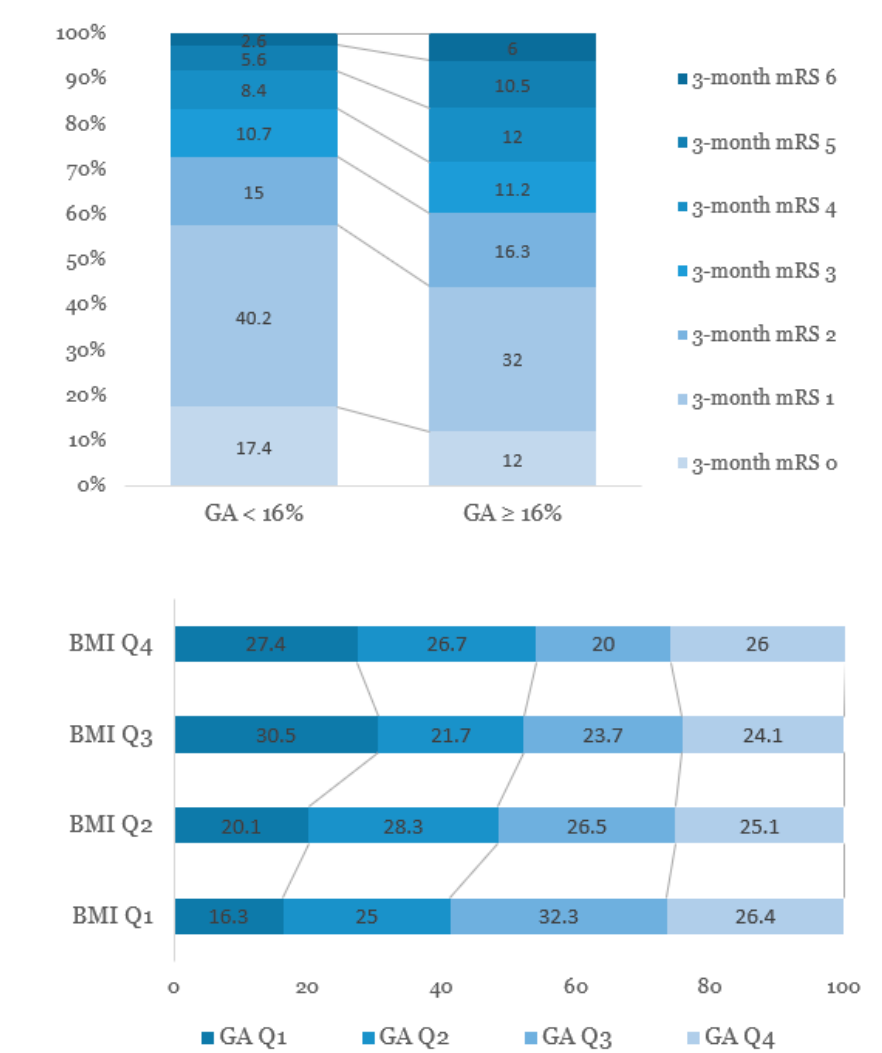
Figure 2. ( A ) Distribution of mRS scores at three months after stroke onset according to the levels of glycated albumin. ( B ) Associations between quartiles of glycated albumin and obesity status based on body mass index. GA, glycated albumin; BMI, body mass index; Q, quartile; mRS, modified Rankin Scale.